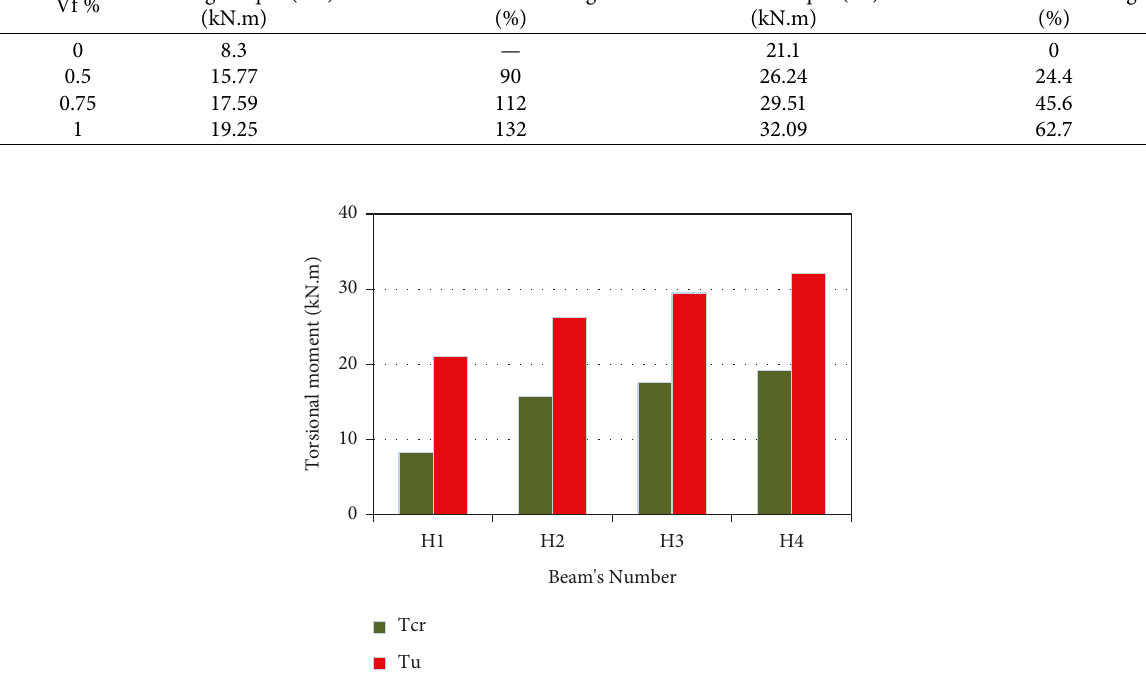
Figure 10: Torsional moment of the tested beams.